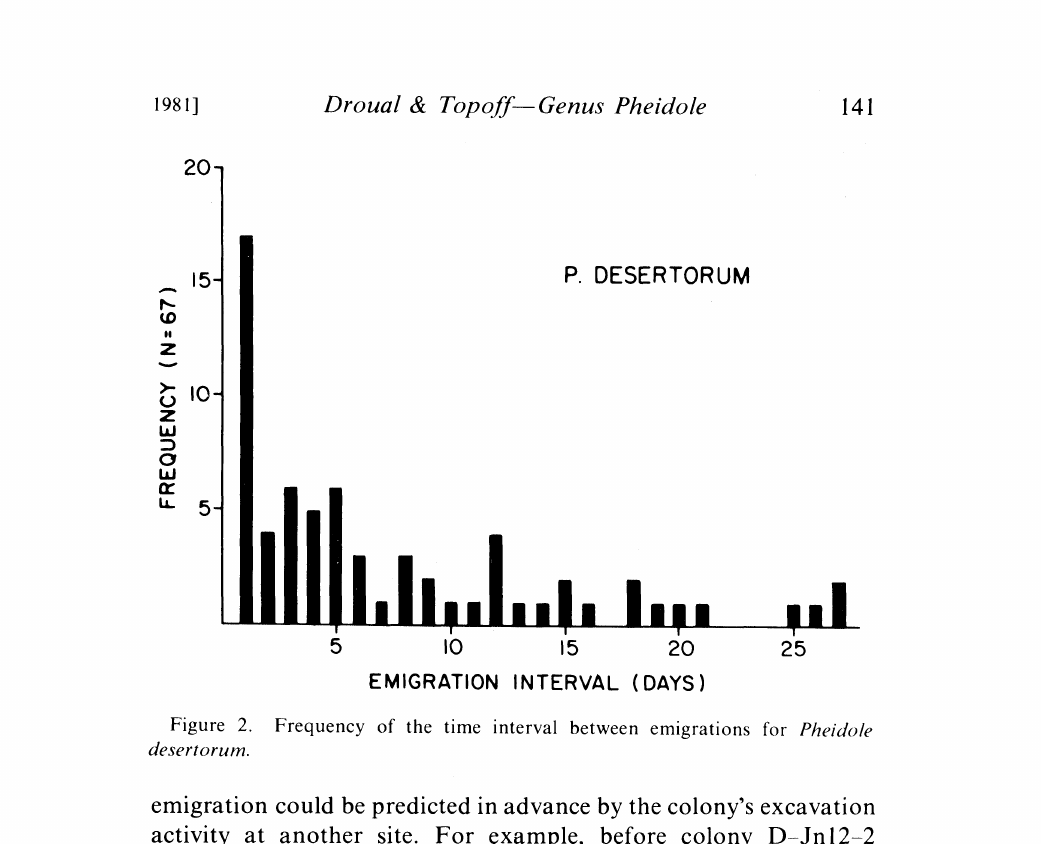
Figure 2. Frequency of the time interval between emigrations for Pheidole